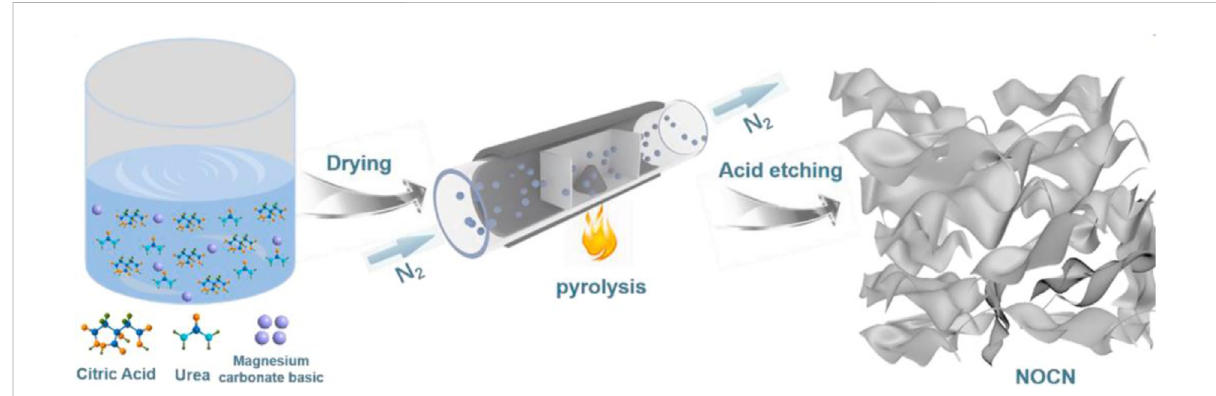
FIGURE 15 Schematic illustration of the synthetic procedure for NOCN (Ran et al.,